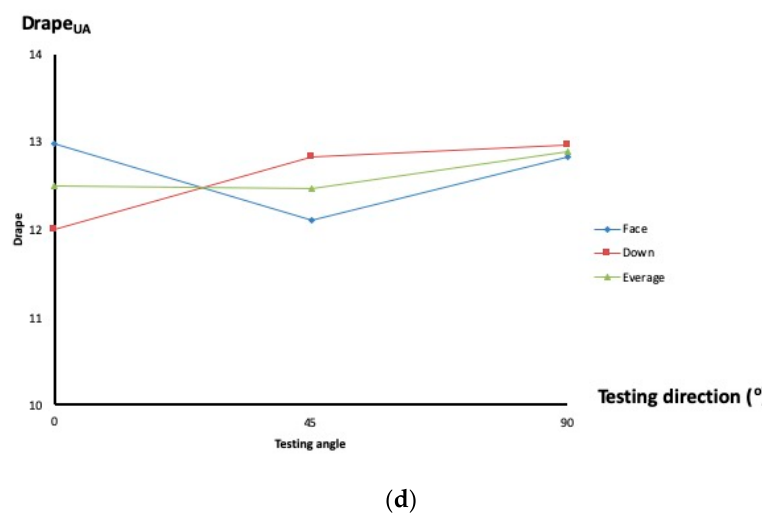
Figure 10. ( a ) Directional and side effects for Sample #36; ( b ) directional and side effects for Sample #23; ( c ) directional and side effects for Sample #30; and ( d ) directional and side effects for Sample #29.